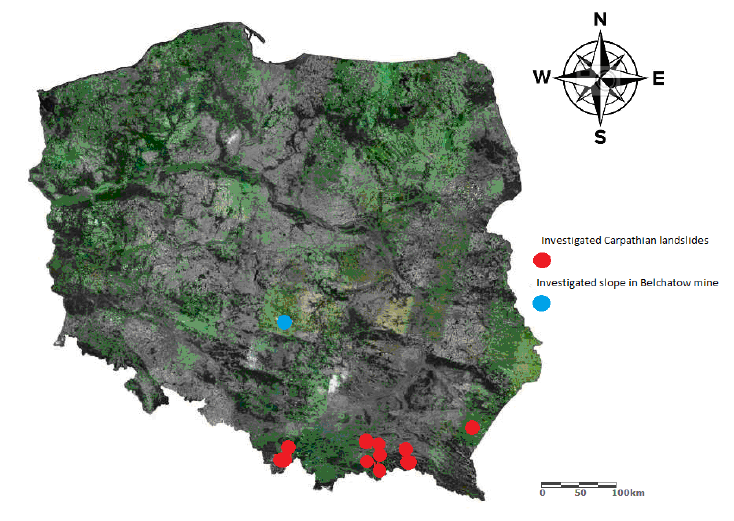
Figure 1. Localization of the investigated landslides and slopes.